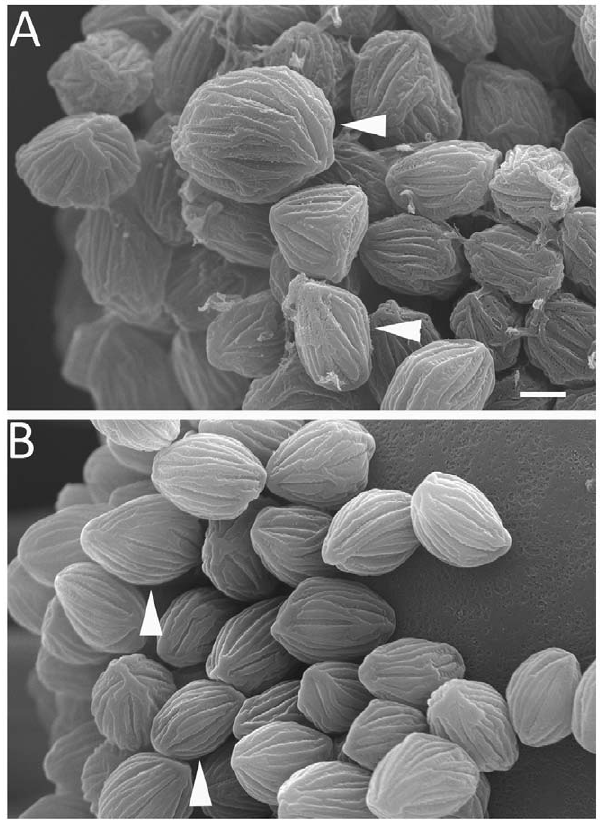
Figure 5. Main pattern of asexual sporangiospore micromor- phology. (A) Rhizopus delemar NRRL3562. (B) R. oryzae NRRL2908. Arrows show the variation in spore size on the same sporangium ( 6 5000). Scale bar=1 m m.